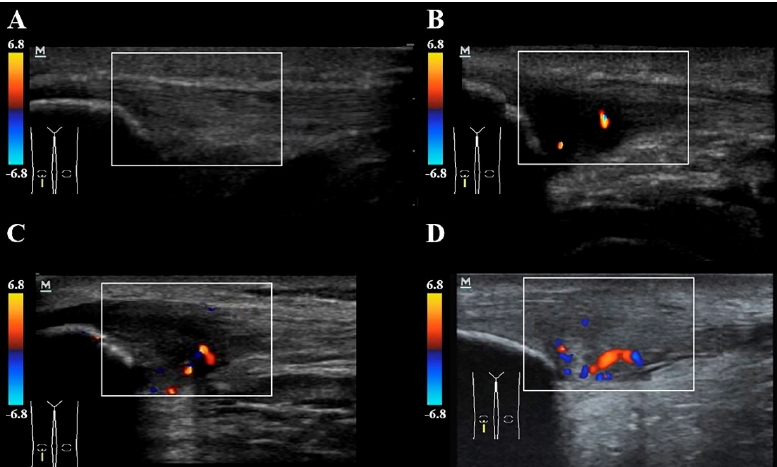
Figure 3. Intra-tendinous Doppler analysis for identifying neovascularization ( A ) grade 0: no visible vessels; ( B ) grade 1: 1 to 2 vessels within the ROI; ( C ) grade 2: 3 to 5 vessels within the ROI; ( D ) grade 3: vessels in up to 30% of the ROI. ROI: Region of